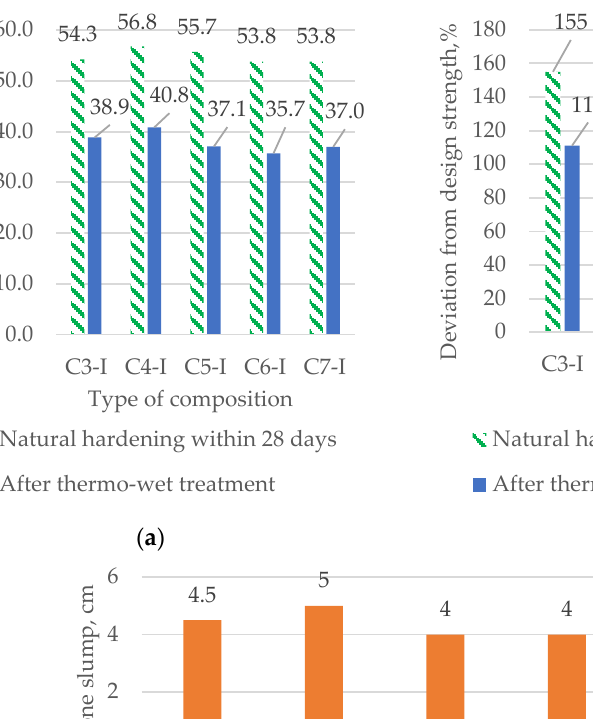
( b ) Figure 1. Images of newly made chips of fine-grained concrete coated with an indicator of 0.1 % phenolphthalein solution: ( a ) composition С1–I; ( b ) composition C2-I.